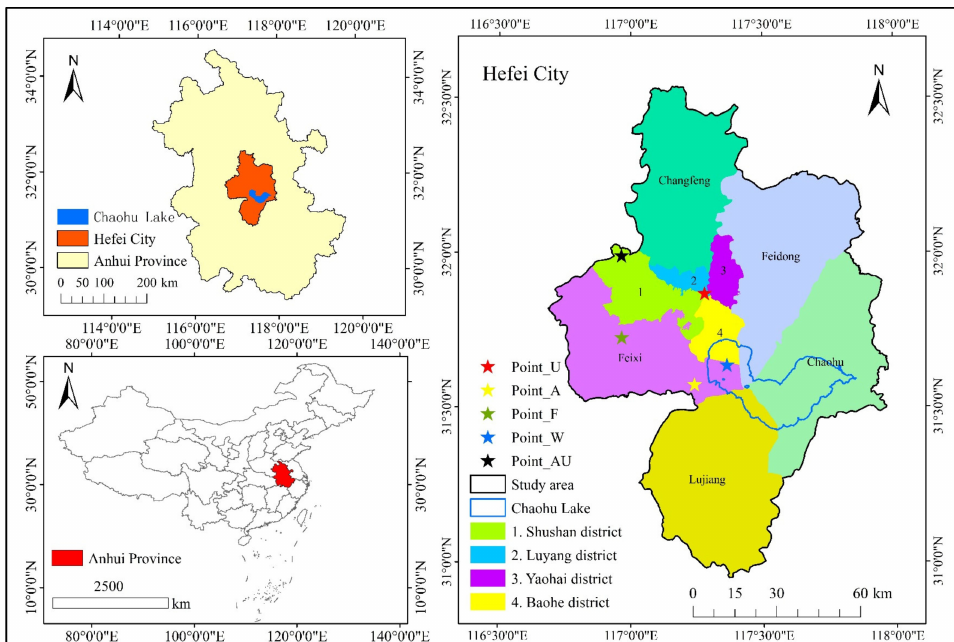
Figure 1. Location map of the study